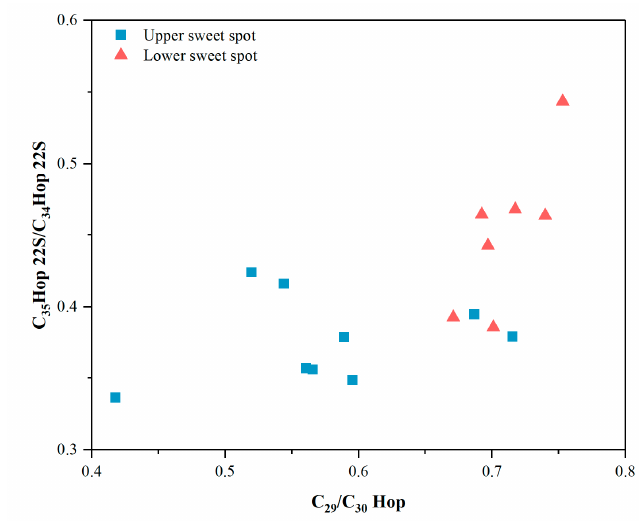
Figure 13. Plot of C 35 22S hopane / C 34 22S hopane vs. C 29 norhopane / C 30 hopane, showing the suboxic to anoxic water column of the Lucaogou formation.